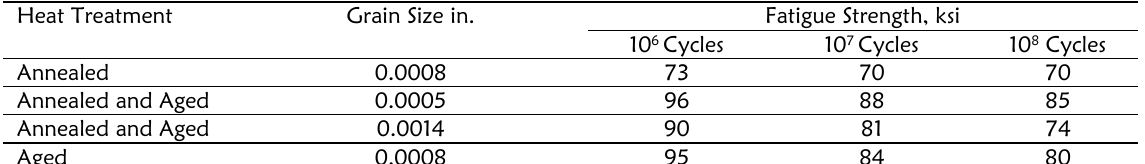
Table 8: Room temperature fatigue strength of wrought IN718 subjected to different heat treatments according to AMS-5596 Standard [63].